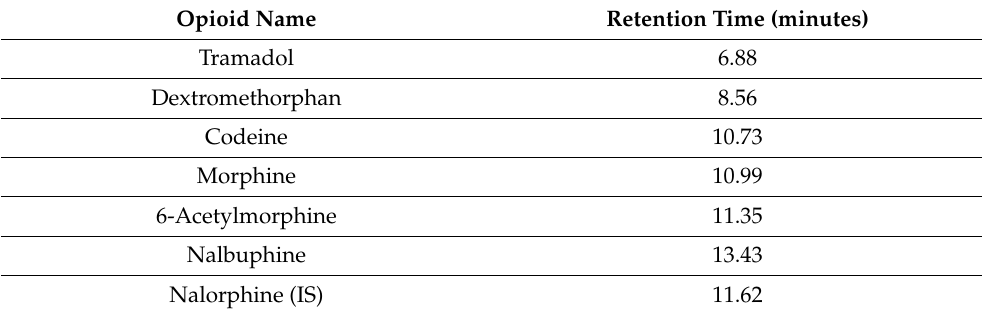
Figure 1. Standard—ion chromatogram. Table 3. Target opioid with relevant retention time on